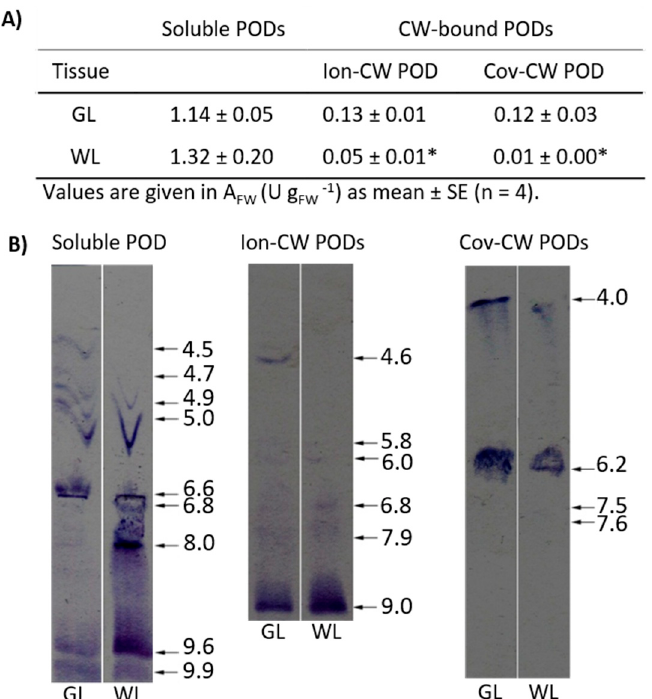
Figure 5. The activities and profiles of soluble, ionic, and covalent cell wall-bound peroxidases (Ion-CW POD and Cov-CW POD) in GL and WL leaf sectors of P. zonale plants grown under optimal conditions. ( A ) Specific POD activities (A FW , U g –1 FW ) represent means ± SE (n = 4). Significant differences between WL and GL, according to the t -test are indicated (* p < 0.05). ( B ) POD isoforms separated by IEF (pH gradient 3–10) and stained with 4-chloro- α -naphthol. The arrows indicate POD isoforms. In total, 40 µg of proteins were applied to each lane.